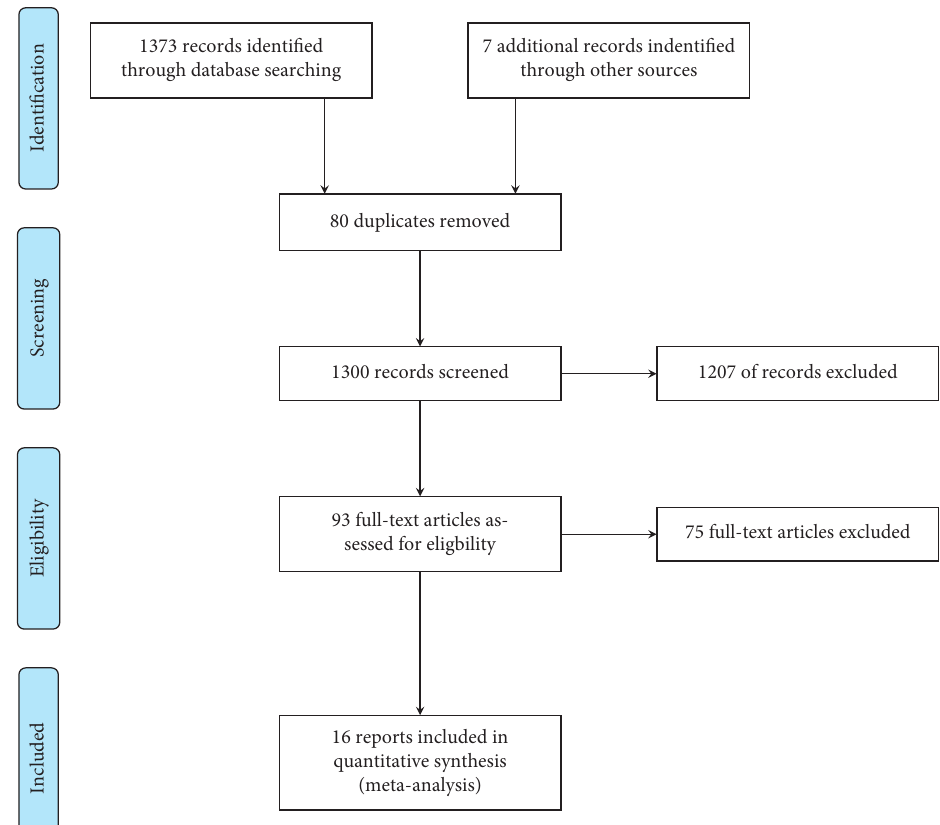
Figure 1: Flowchart of studies